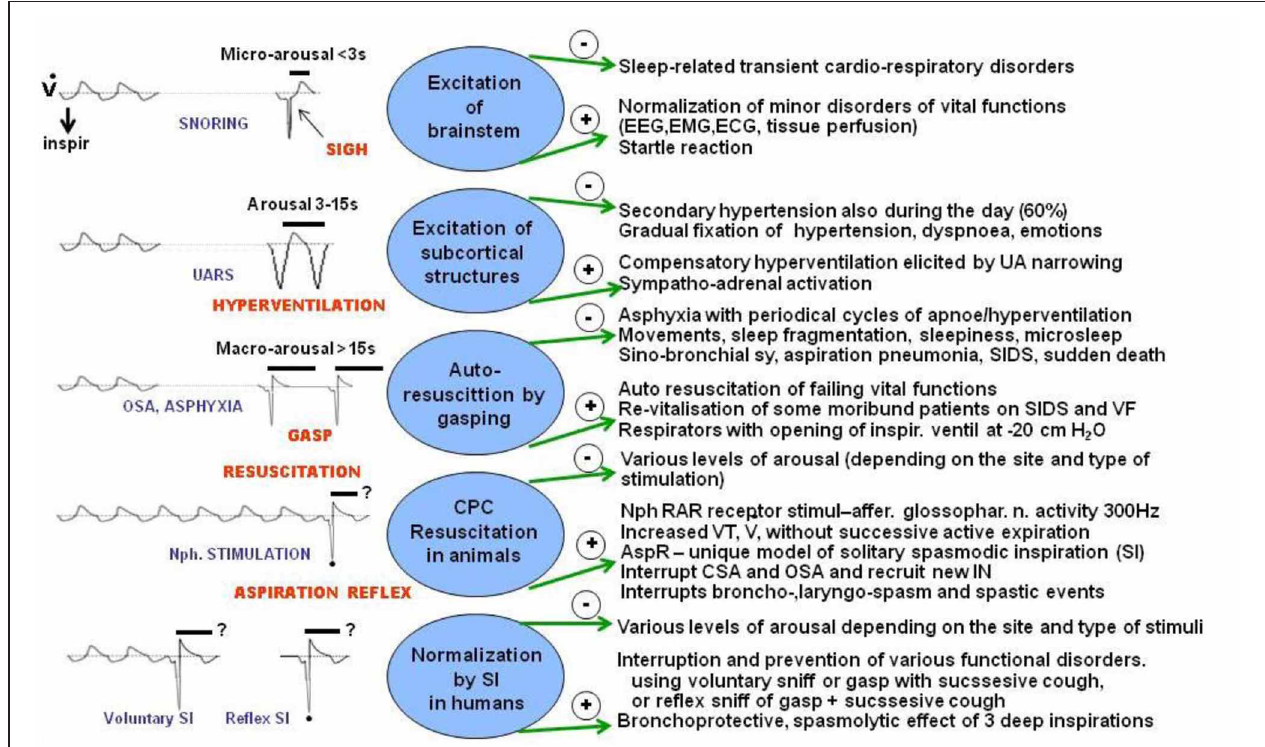
FIGURE 6 | Effects of various respiratory reactions coupled with different degrees of arousal compared with AspR and its counterparts. Schematic illustration of negative ( − ) and positive ( + ) effects of various respiratory efforts coupled with different levels of arousal, gasping auto-resuscitation, and revitalization by AspR and spasmodic inspirations. Some effects, caused